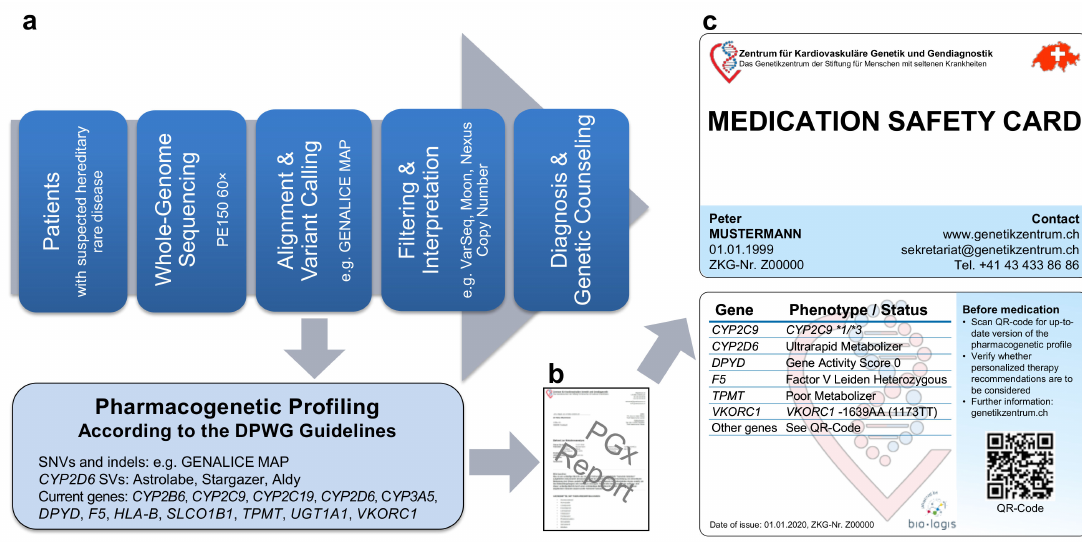
Figure 1. Our whole-genome sequencing (WGS)-based pharmacogenetic (PGx) profiling. ( a ) Pipeline from whole-genome sequencing data to ( b ) PGx report and ( c ) individualized PGx profile in credit card format (Medication Safety Card). Abbreviations: DPWG, Dutch Pharmacogenetic Working Group; indels, insertions / deletions; SNVs, single nucleotide variants; SVs, structural